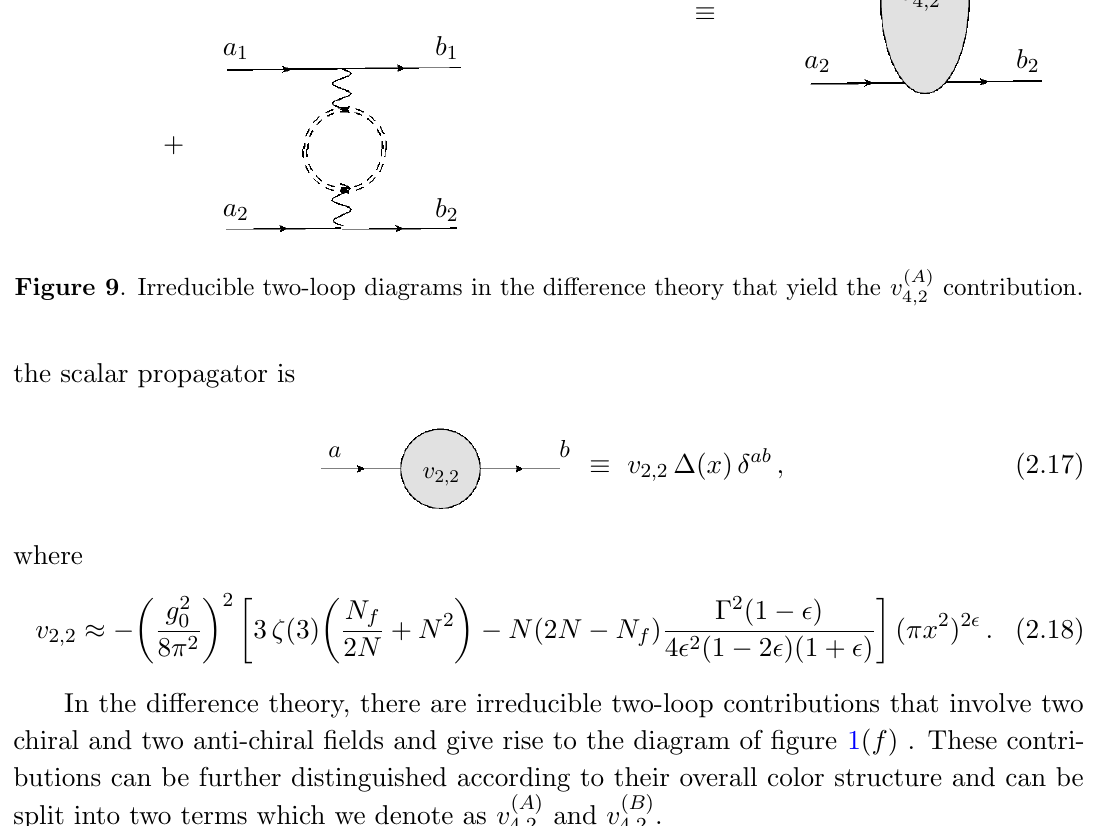
Figure 9 . Irreducible two-loop diagrams that correct the ϕ propagator in the difference